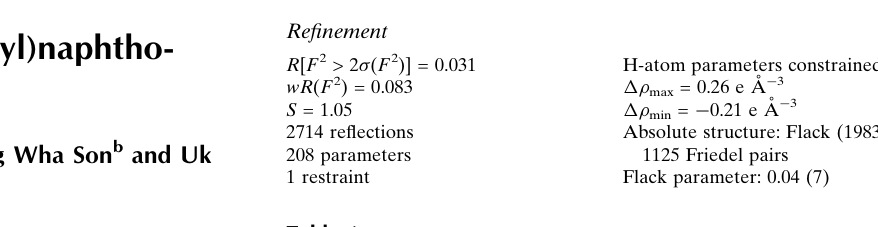
Selected interatomic distances (A˚ ).